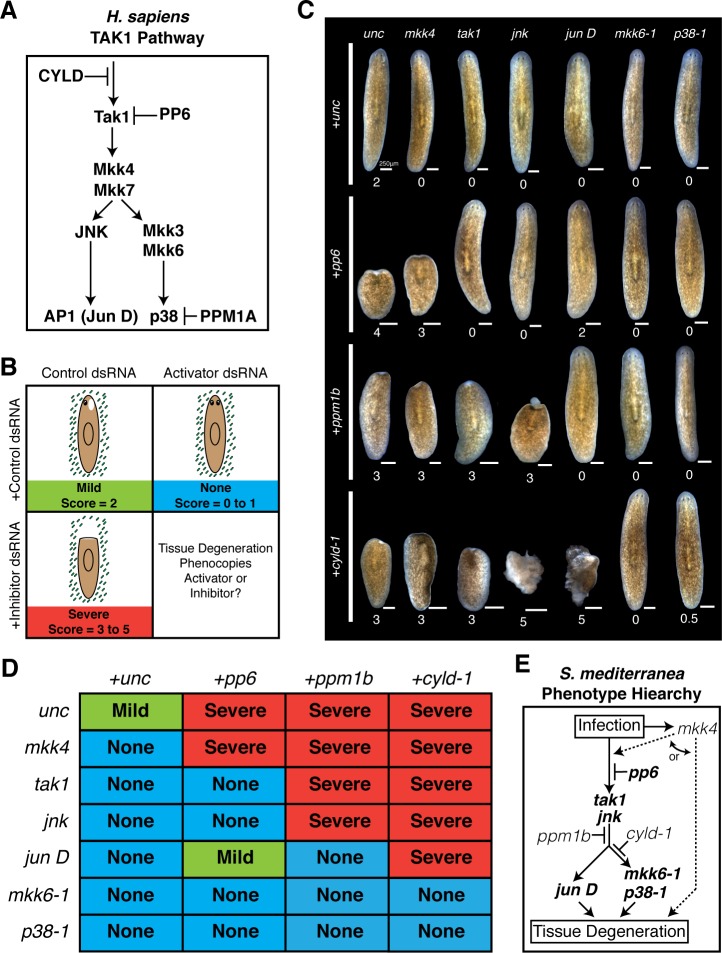
Epistatic analysis of activators and inhibitors of planarian pathological progression.(A) Diagram depicting relevant components of the TAK1 pathway in Homo sapiens. (B) Diagram depicting combinatorial RNAi experiment and assay of tissue degeneration outcome. (C) Representative images and median pathological stage of worms following RNAi treatment with each combination of 6 activators and 3 inhibitors 12 days post Pseudomonas infection (n = 6–24). (D) Table of phenotypic outcomes following combinatorial RNAi treatment and Pseudomonas infection. (E) Diagram depicting phenotypic hierarchy of the mediators of pathological progression in Schmidtea mediterranea (bold = order is consistent with Homo sapiens TAK1 Pathway).DOI:
http://dx.doi.org/10.7554/eLife.16793.01710.7554/eLife.16793.018Figure 6—source data 1.Pathological scores of worms during combinatorial RNAi analysis.